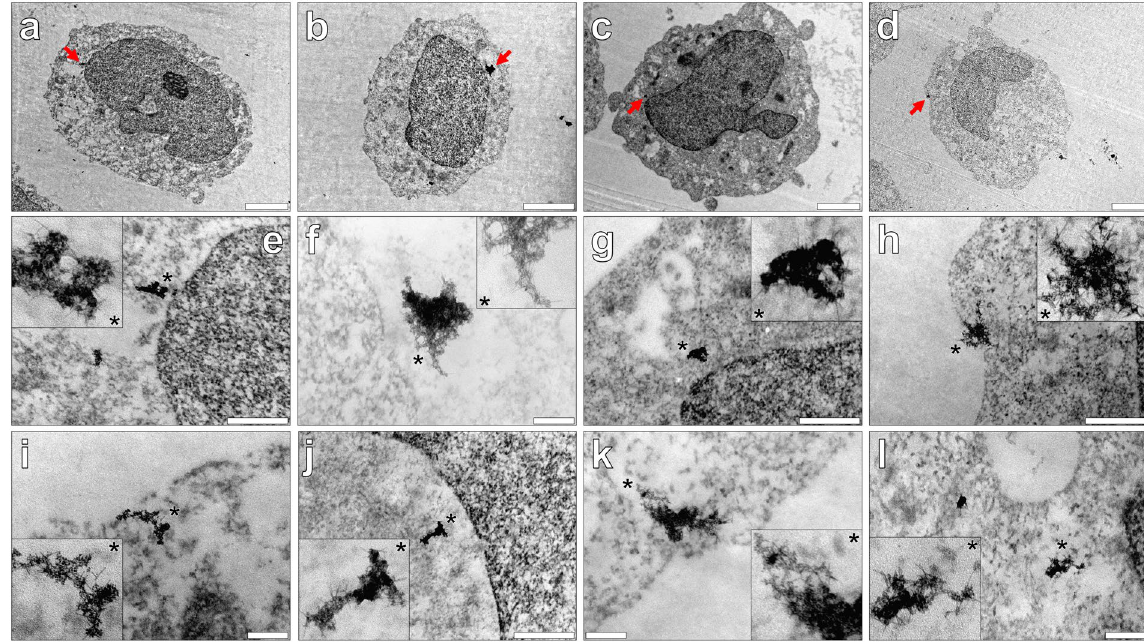
Figure 2. Representative electron micrographs from TEM of Spurr resin-sectioned (100 nm sections) THP-1 cells co-cultured with 4 μ M A β 42 in R10 medium containing 10 μ M thioflavin T (ThT) for ( a,e and i ) 1, ( b,f and j ) 3, ( c,g and k ) 6 or ( d,h and l ) 24 h. Cell resin-sections were stained for 20 min with 2% w/v ethanolic uranyl acetate, rinsed with 30% v/v ethanol followed by ultrapure water. Grids containing sections were allowed 24 h drying time prior to analysis via TEM. Inserts show close-ups of intracellular negatively stained amyloid deposits and the red arrows highlight their presence within the respective cell images ( e – h ). A further example of intracellular negatively stained amyloid fibrils observed at 1, 3, 6 and 24 h, is also depicted ( i – l ). Magnification & scale bars: ( a and c ). X 10 K, 2 μ m, ( b ) X 12 K, 2 μ m, ( d ) X 8 K, 2 μ m, ( e–h ) X 60 K, 0.5 μ m & ( i–l ) X 100 K, 0.2 μ m,